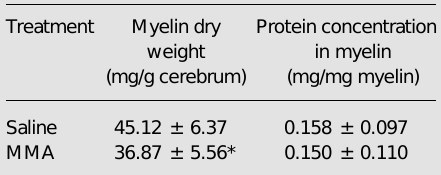
Table 2 - Effect of chronic administration of methylmalonic acid (MMA) on dry myelin content and myelin protein concentration in rat cerebrum. Data are reported as means ± SD for 6 rats in each group. *P<0.05 compared with the saline group (Student t